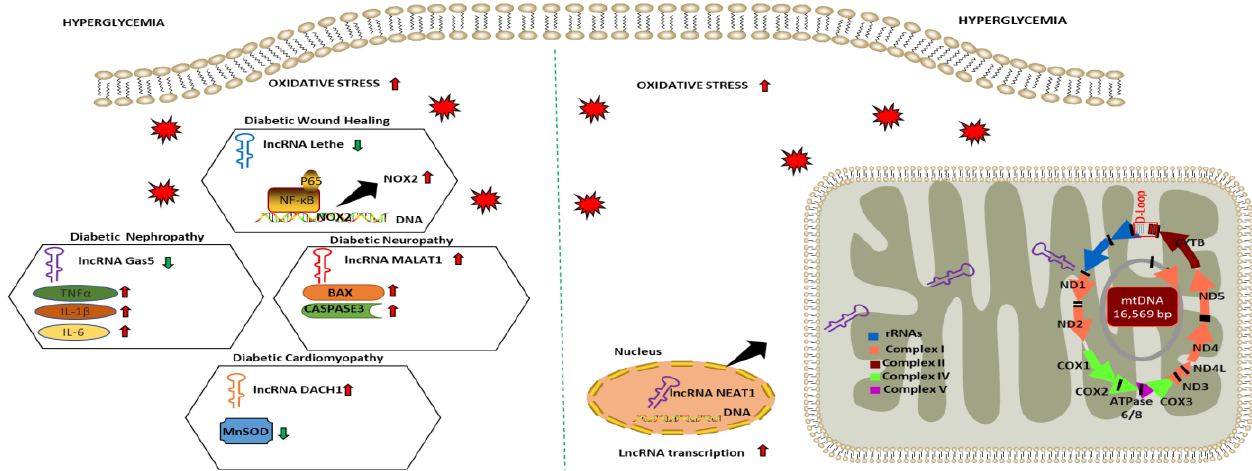
Figure 2. Dysregulated lncRNA and their role in regulating oxidative stress and mitochondrial function in diabetic complications. Arrows indicate the direction of changes in the expression or function. lncRNA: Long non-coding RNA; Gas5: Growth arrest specific transcript 5; DACH1: Dachshund homolog 1; NEAT1: Nuclear paraspeckle assembly transcript 1; NOX2: NAPDH